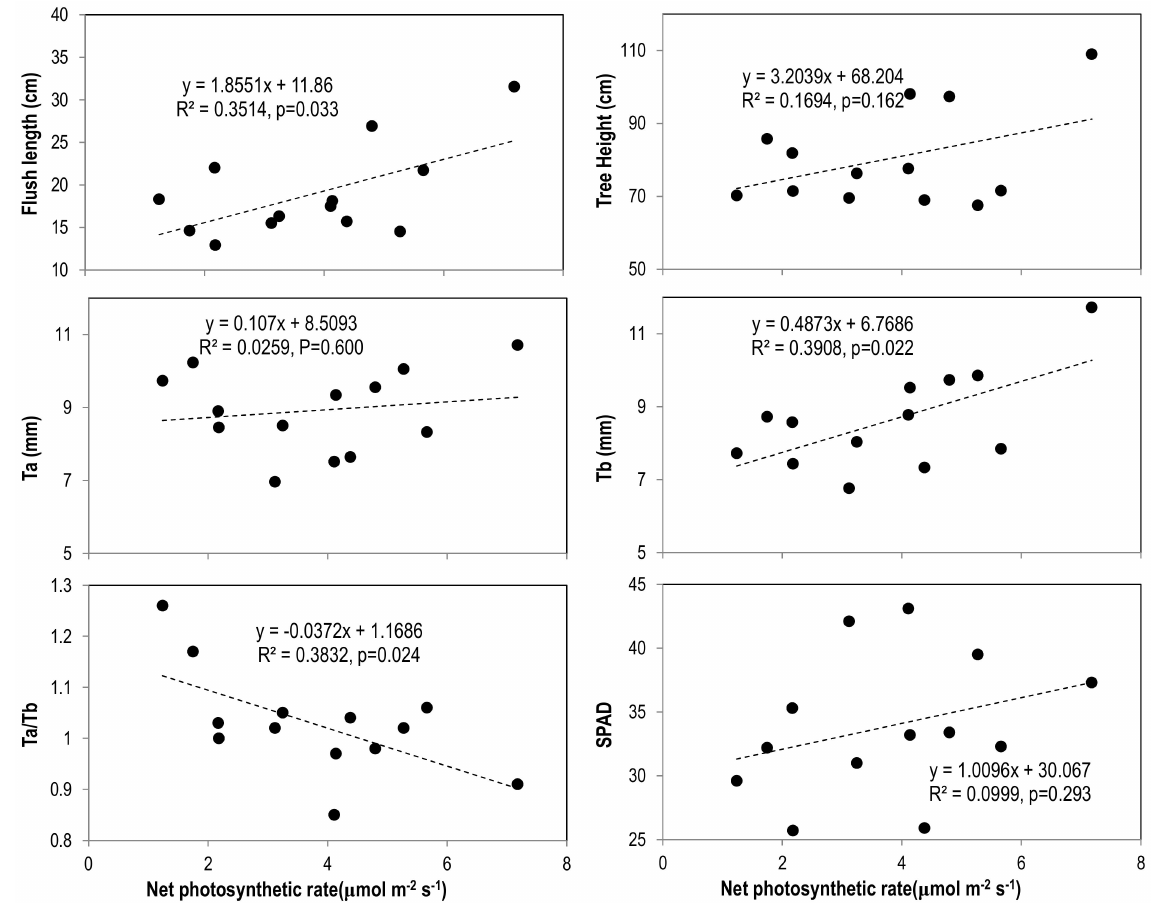
Figure 3. Linear correlation analysis of net photosynthetic rate with flush length, tree height, stem thickness above (Ta) and below (Tb) graft joint, and leaf SPAD